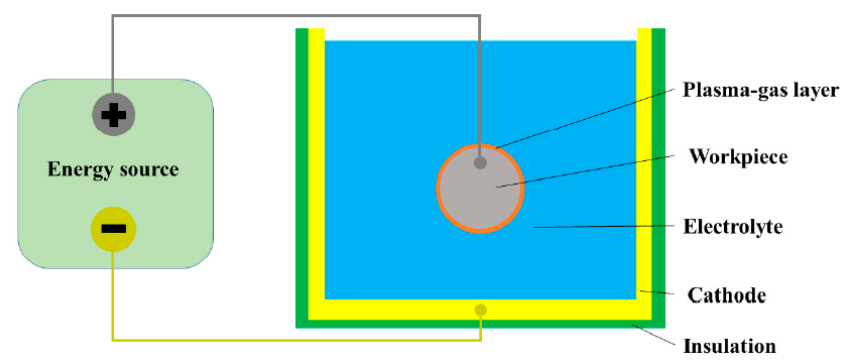
Figure 34. Schematic diagram of the electrolyte plasma polishing system [74] .